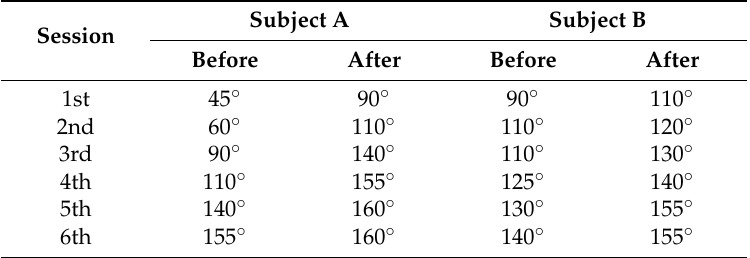
Table 1. Knee joint flexion amplitude before and after acupuncture sessions.